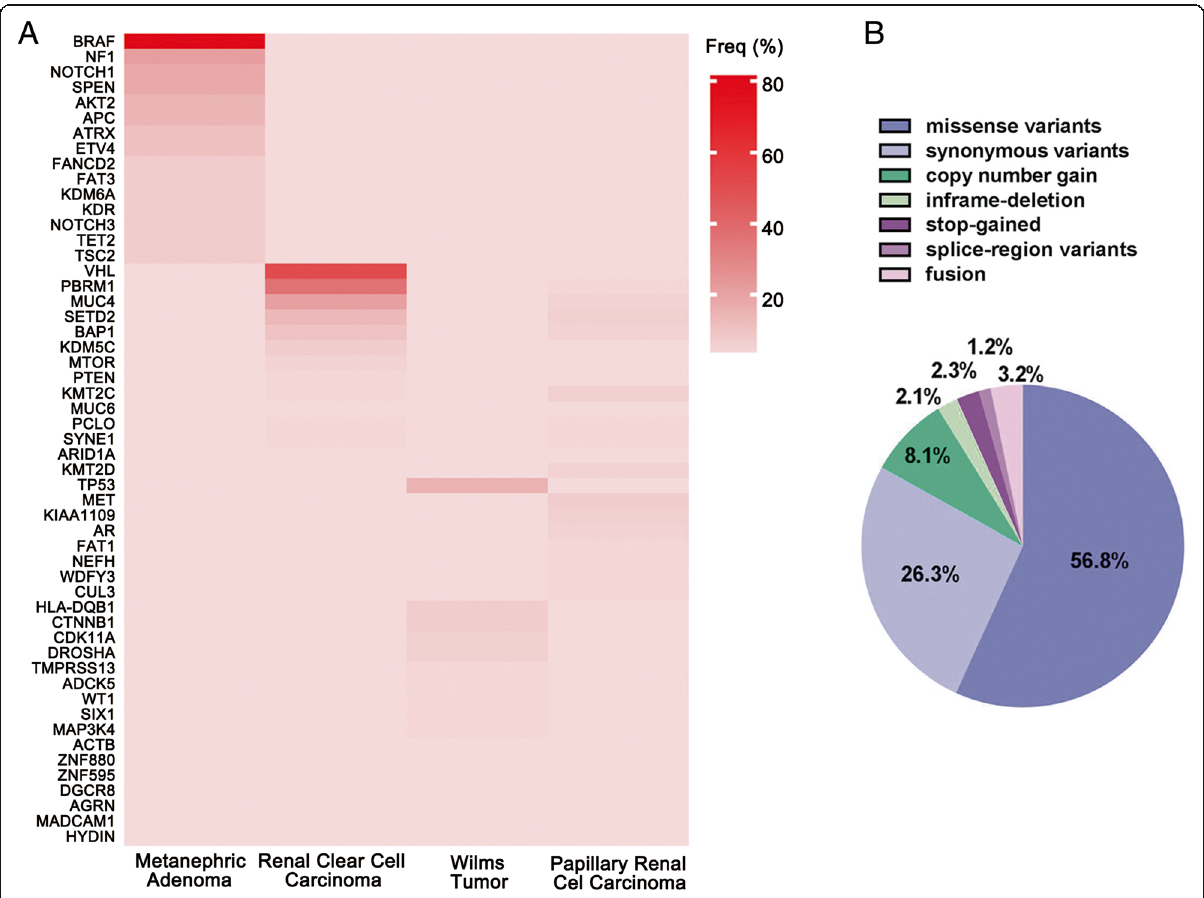
Fig. 2 a The somatic mutation spectrum in different renal carcinoma. The hybrid capture-based NGS was used to sequence a panel of 295 well- established oncogene or oncosuppressors. In each analyzed MA patient, 85 somatic mutational events were detected. b The ratio of different mutant species in MA. The vast majority of mutation types were missense and synonymous variants (56.8 and 26.3%, respectively), while a smaller percentage was represented by copy number gain, indel, stop-gained, splice-region variants, or fusion (8.1, 2.1, 2.3, 1.2 and 3.2%,